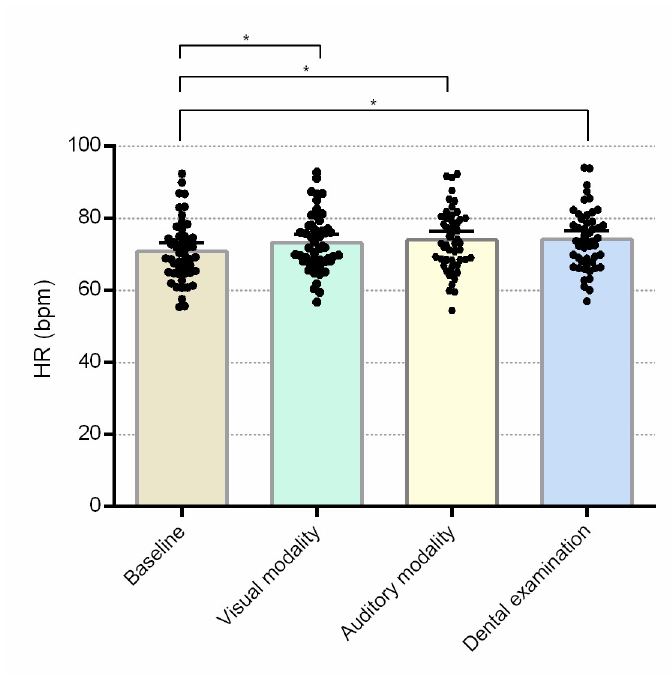
Fig 1. Mean heart rate during different experimental conditions. Error bars indicate a 95% confidence interval; � p < 0.001; units are in bpm (beats per minute).